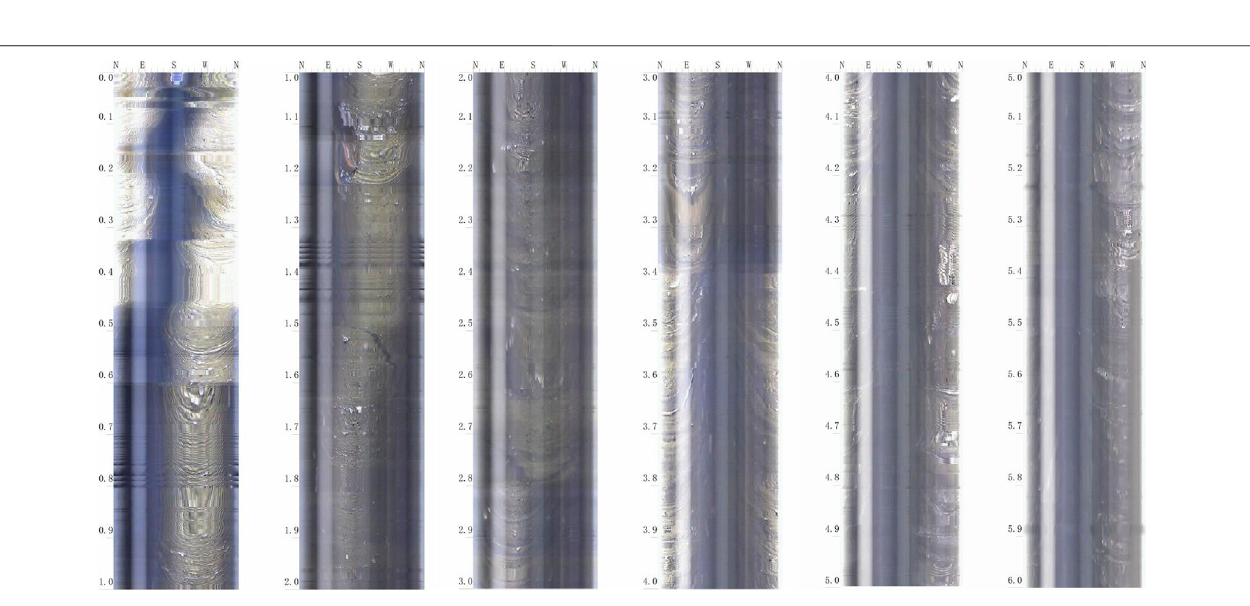
Frontiers in Earth Science |